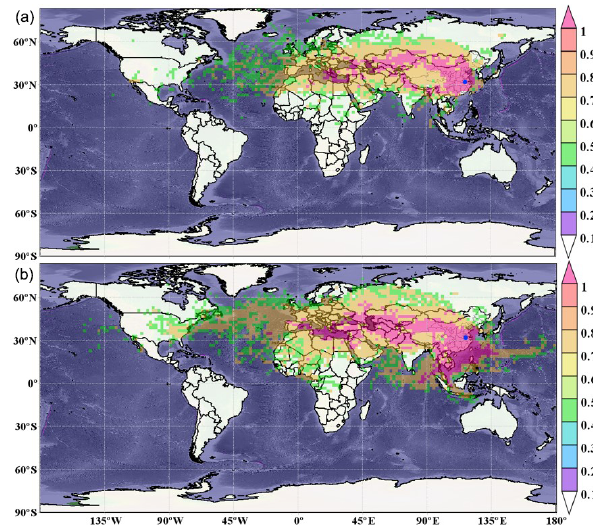
Figure 12. Likely source areas of air mass associated with higher HCN concentrations at Hefei (32 ◦ N) in (a) the first half year and (b) the second half year, identified using